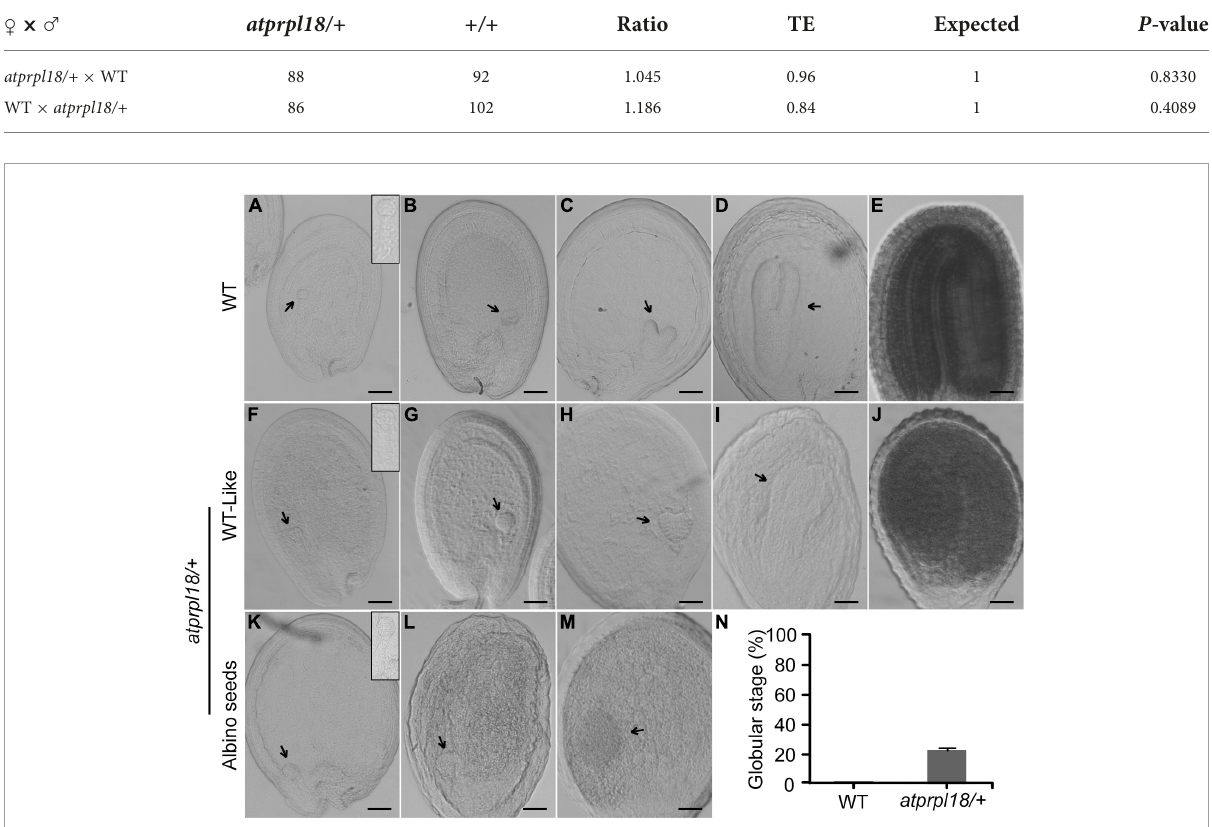
FIGURE4 Comparison of the embryo development in WT and atprpl18/+ mutant. (A–E) Various developmental stages of WT embryos. (A) 4-cell, (B) globular, (C) heart, (D) torpedo, (E) mature. (F–J) WT-like embryos from the developing siliques of atprpl18/+ mutant. (K–M) Abnormal embryos from the albino seeds of atprpl18/+ mutant. The magnified views of embryos from (A,F,K) were shown on the top right of the graphs. (N) The rate of arrested embryos in the 9 DAF siliques of WT and atprpl18/+ mutant plants. Eight siliques for each genotype plants were examined. The rate of embryos arrested at globular stage per silique was calculated. Data represent means ± SD. This experiment was repeated twice with similar results. Scale bars = 50 µ m (A–M)